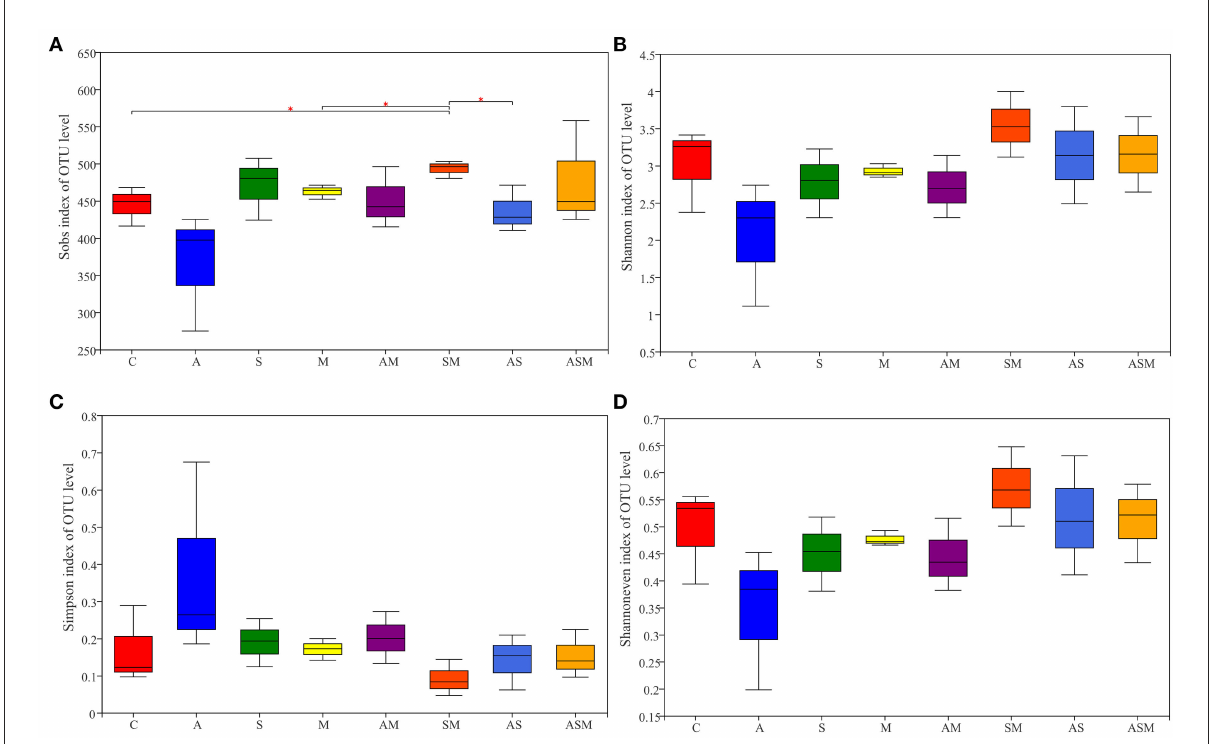
FIGURE6 Species richness and diversity index of soil fungi of A. adsurgens . (A) OTU richness estimated by sobs index; (B) Shannon diversity; (C) Simpson diversity; (D) Shannon’s evenness. C, non-inoculated control; A, inoculation with Alternaria chlamydospora ; S, inoculation with Sarocladium kiliense ; M, inoculation with Monosporascus sp.; AS, co-inoculation of Alternaria chlamydospora and Sarocladium kiliense ; AM, co-inoculation of Alternaria chlamydospora and Monosporascus sp.; SM, co-inoculation of Sarocladium kiliense and Monosporascus sp.; ASM, combination inoculation of the three